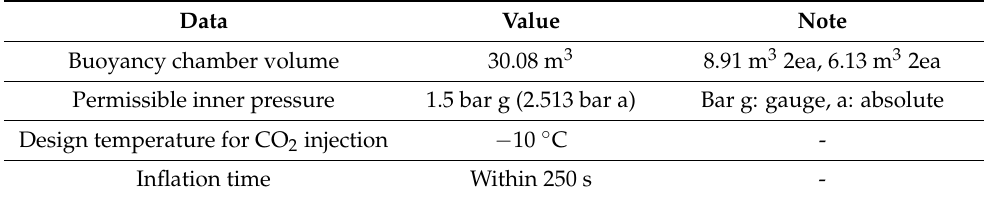
Table 6. Buoyancy chamber design